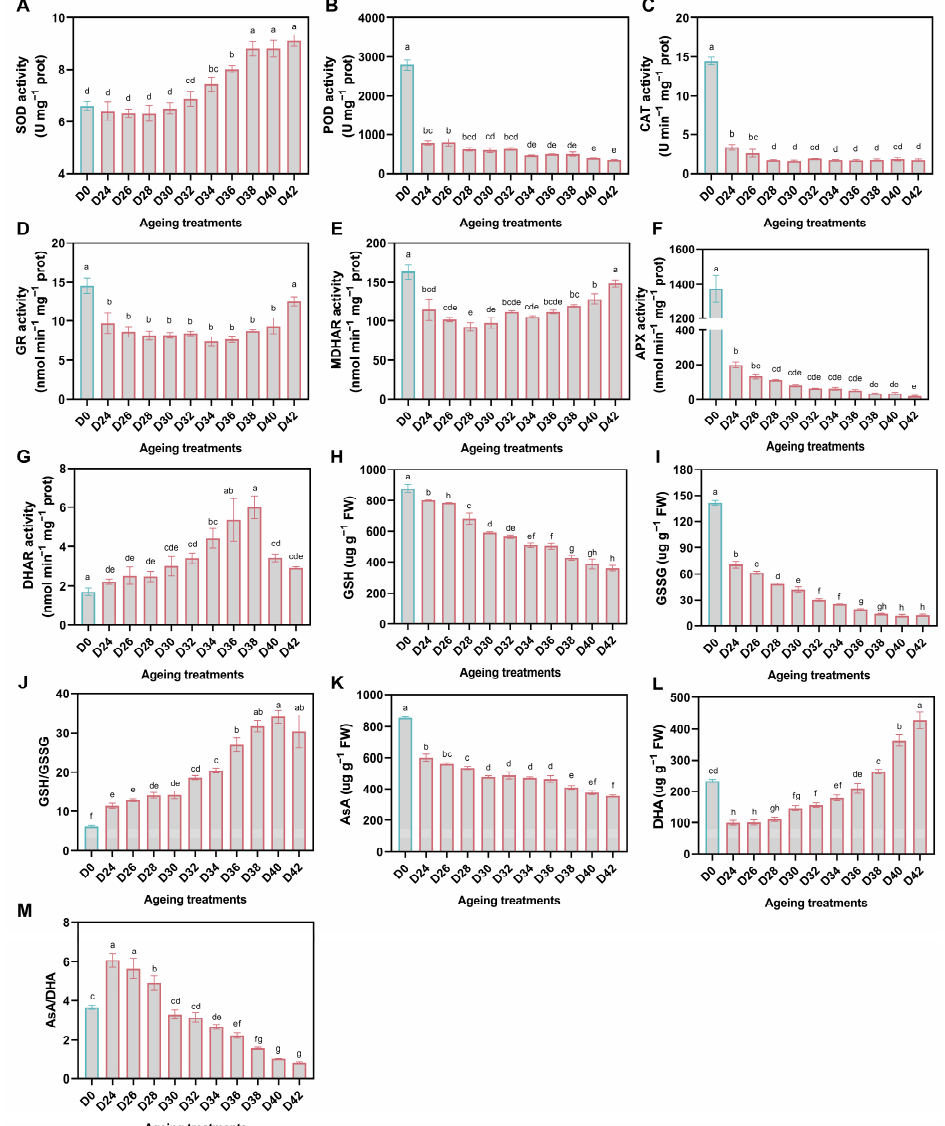
Figure 5. Effect of aging treatment on the activity of antioxidant enzymes ( A – G ), the content of non-enzymatic antioxidants ( H , I , K , L ), and the ratio of reduced and oxidized antioxidants ( J , M ) in oat seeds. The letters represent statistical significance among the treatments and the vertical bars represent the ± SEM at p < 0.05 level for three replicates. The mean values sharing same letters, obtained from Duncan test, are not different significantly.